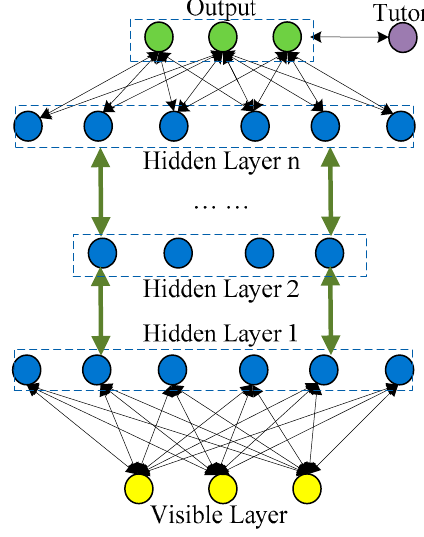
Figure 1. Structure of self-organizing deep neural network (DNN).